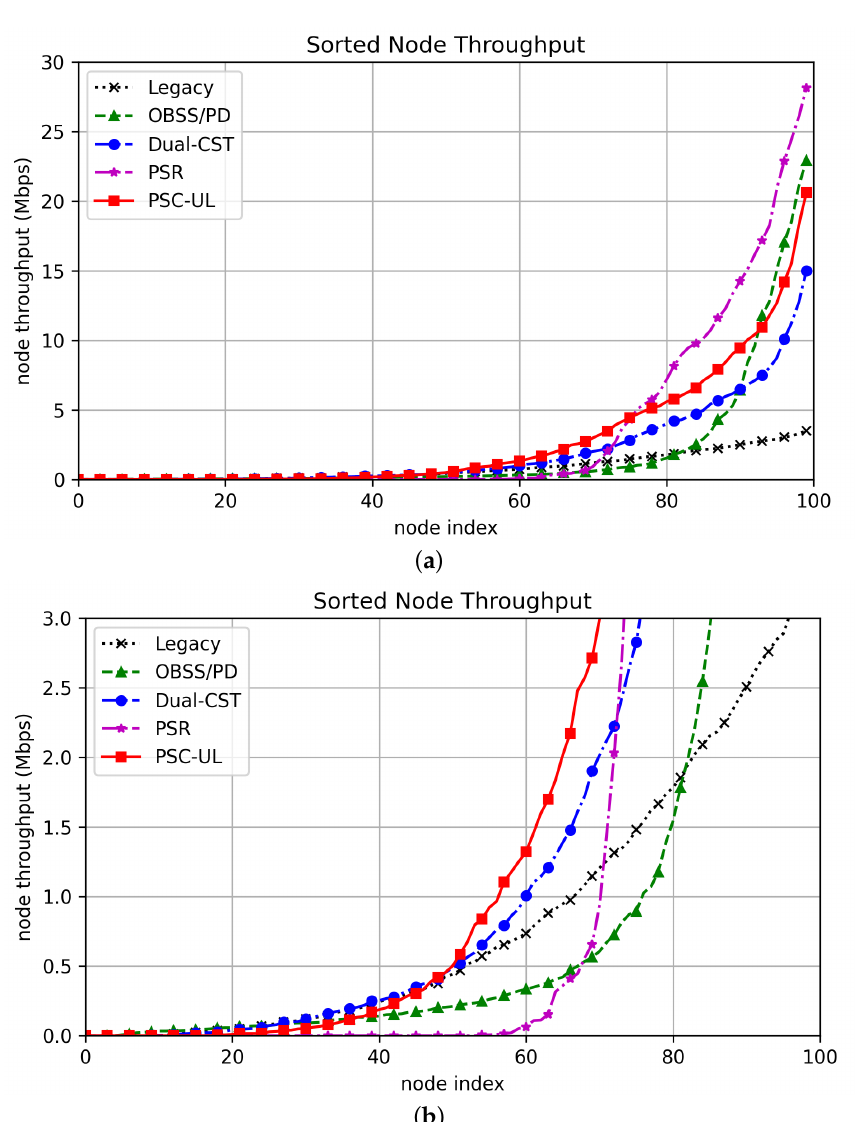
Figure 9. Sorted node throughput. Panel ( a ) is the full graph whereas panel ( b ) is a partial graph where the y-axis is from 0 to 3